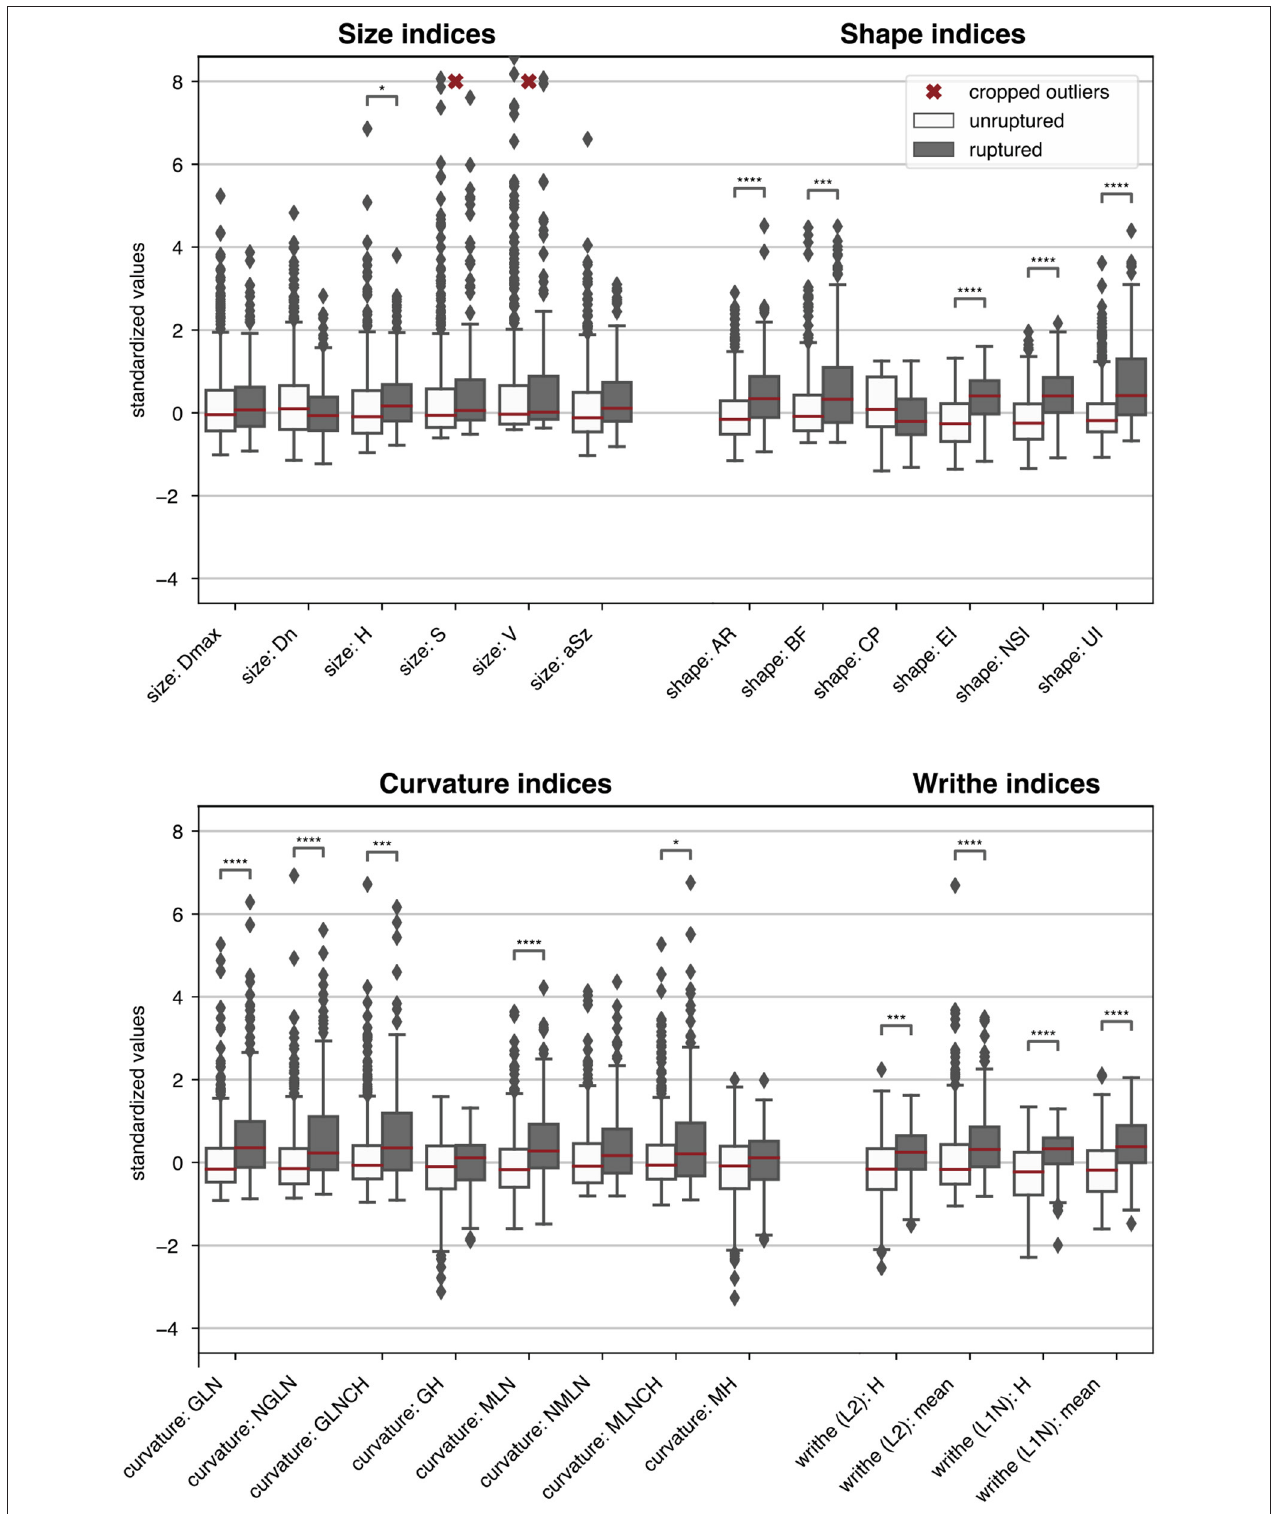
FIGURE 4 | Boxplots summarizing the morphometric data of the 470 HUG samples stratified by rupture status. For easier comparison, each metric was centered and scaled such that the overall median and interquartile range mapped to 0 and 1, respectively. ZMI data was omitted. Single asterisks *, double asterisks **, triple asterisks ***, and quadruple asterisks **** indicate significance for t -tests at the α = 0.05, 0.01, 0.001 and 0.0001 level, under consideration of the Bonferroni correction for multiple testing (correction factor 150). The morphometric parameters are described in Table 1 .